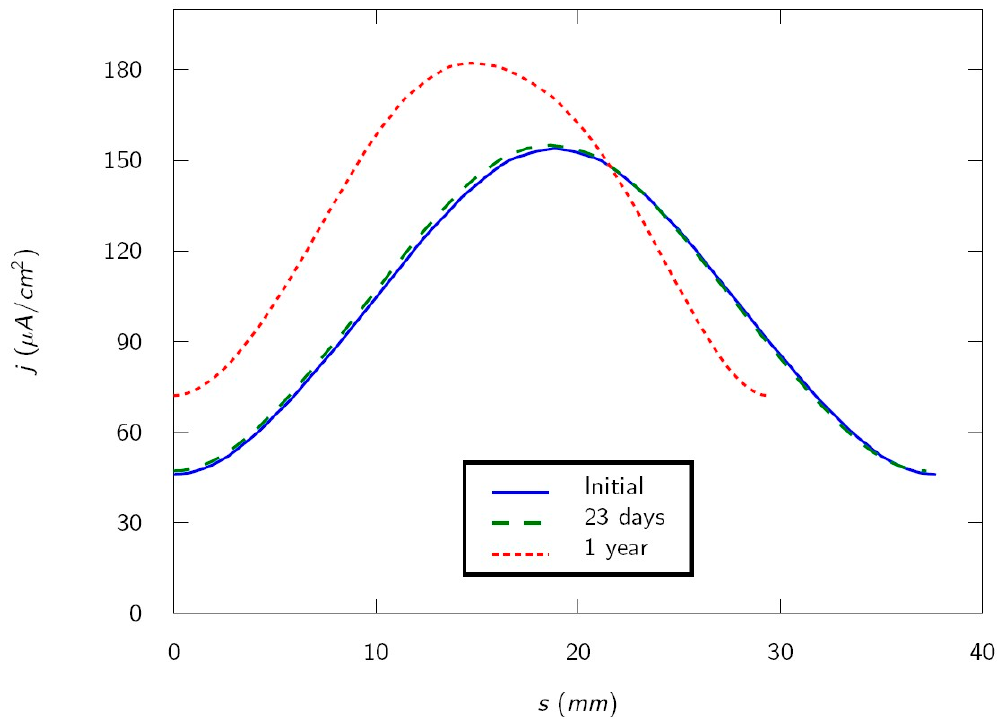
Figure 4. Current density on the perimeter of the rebar at several corrosion times.